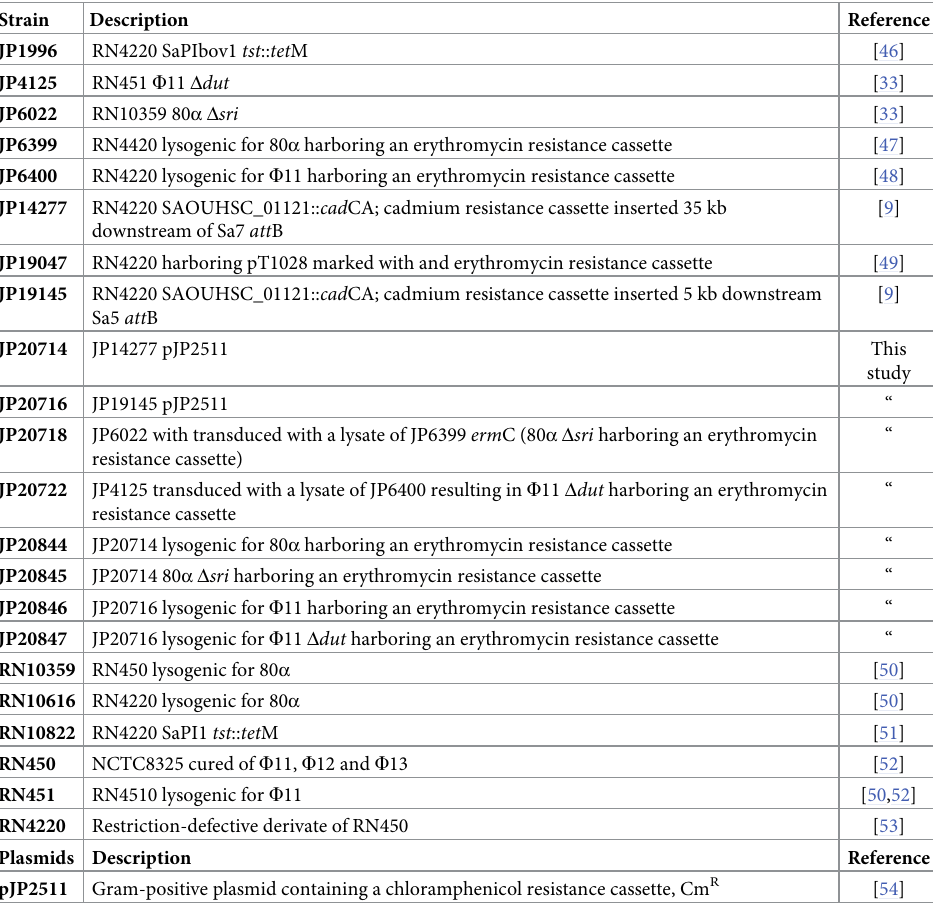
Table 1. Strains and plasmids used in this